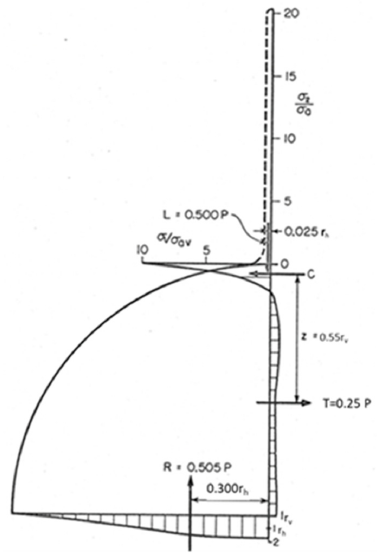
Figure 20. Moment equilibrium conditions obtained from stress distribution in one quarter of the disk.